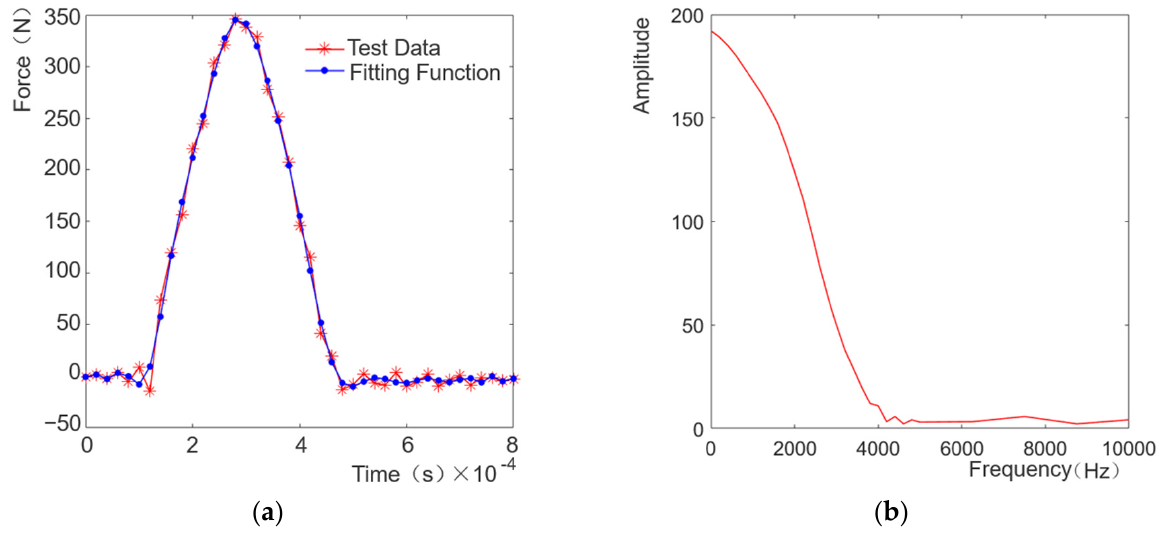
Figure 5. Hammer percussion force signals and spectral characteristics. ( a ) Hammer percussion force signals; ( b ) force signal spectral characteristics.